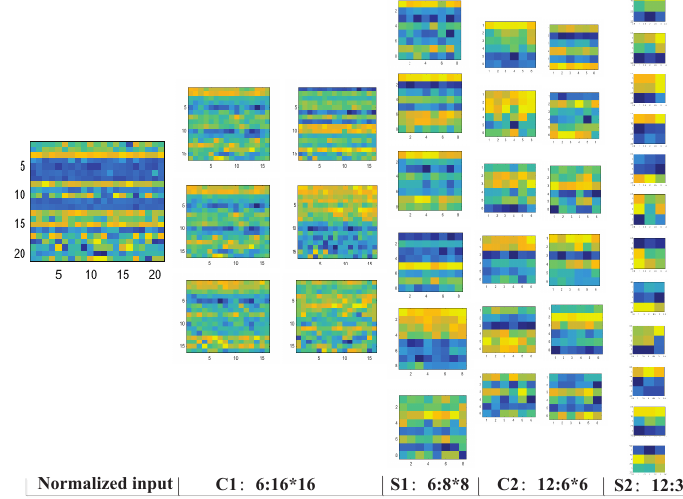
Figure 10. Output process of each layer.